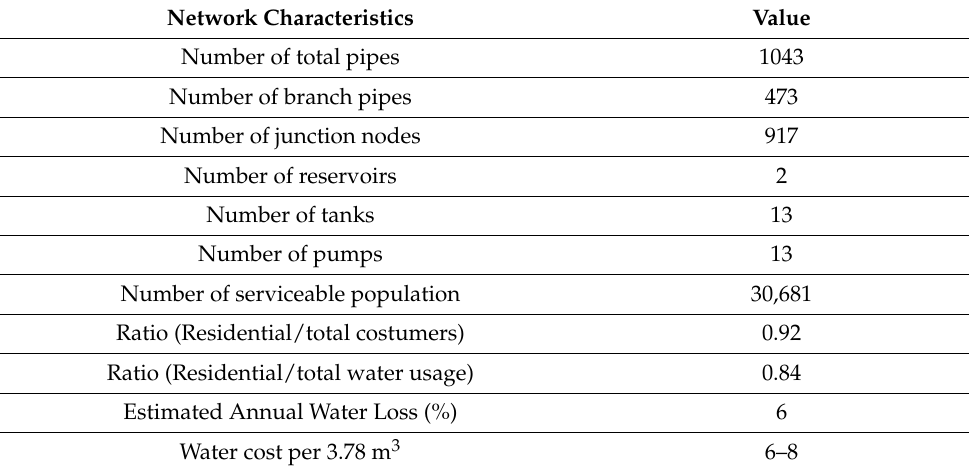
Figure 7. Hourly demand pattern of network nodes.